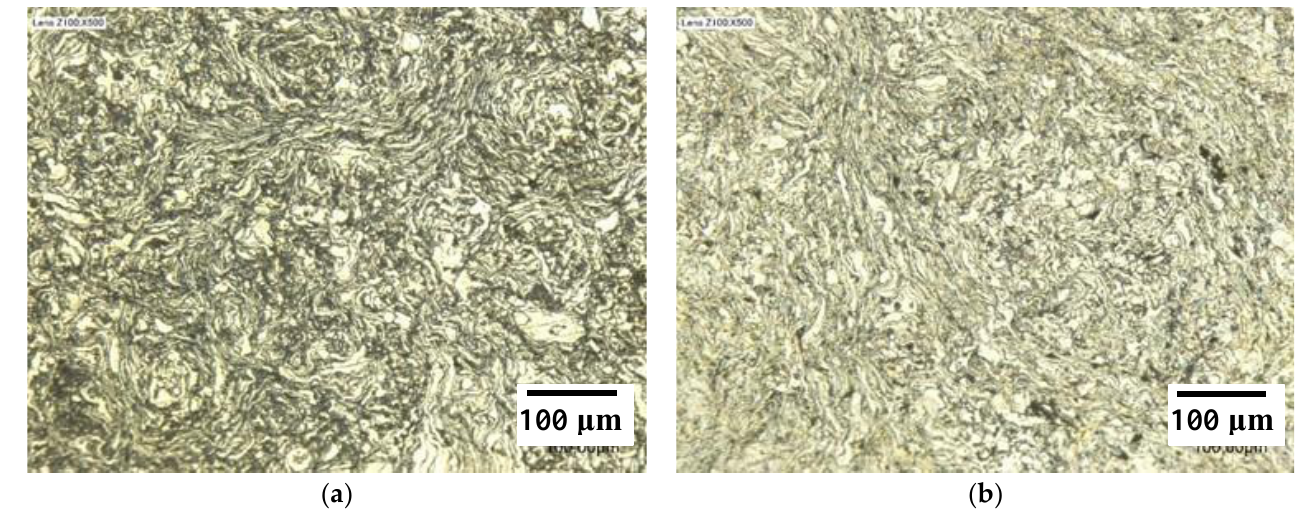
Figure 7. Optical image of selected EAFD/AA7075 composites: ( a ) 10G1-S; ( b )